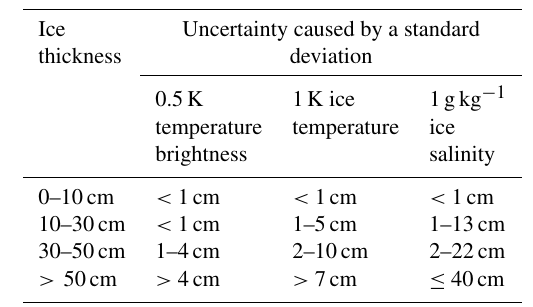
Table 2. SMOS uncertainty.